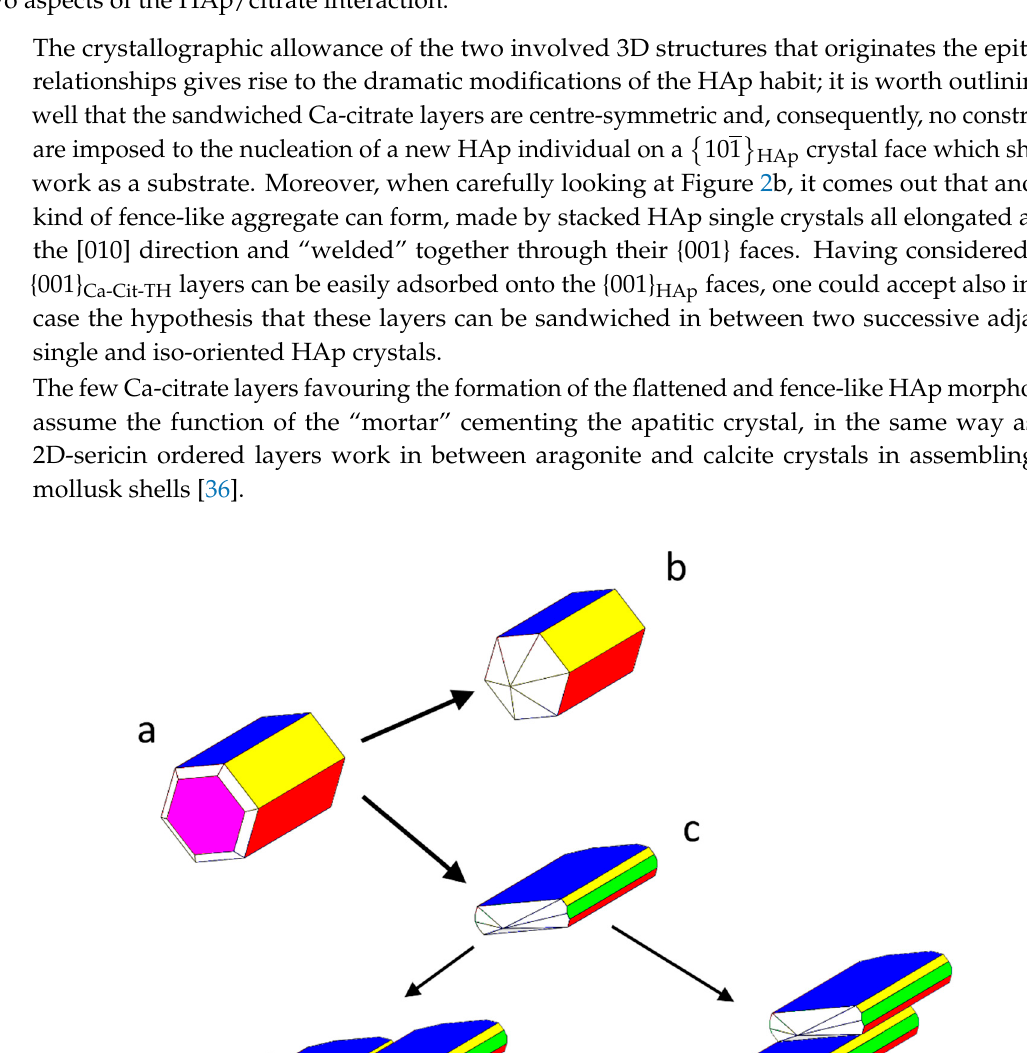
(cid:8) (cid:9) 102 -red. The {010}-purple (cid:8) (cid:9) 101 or {001} faces (or both, (or both,